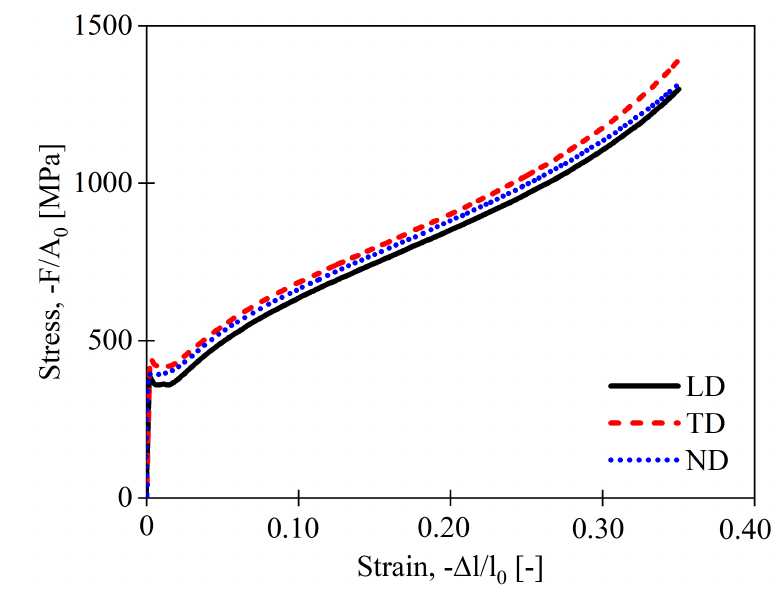
Figure 12. Stress–strain response of WAAM S355JR steel extracted from a compression test in three orthogonal directions. The mechanical properties appear to be nearly isotropic.